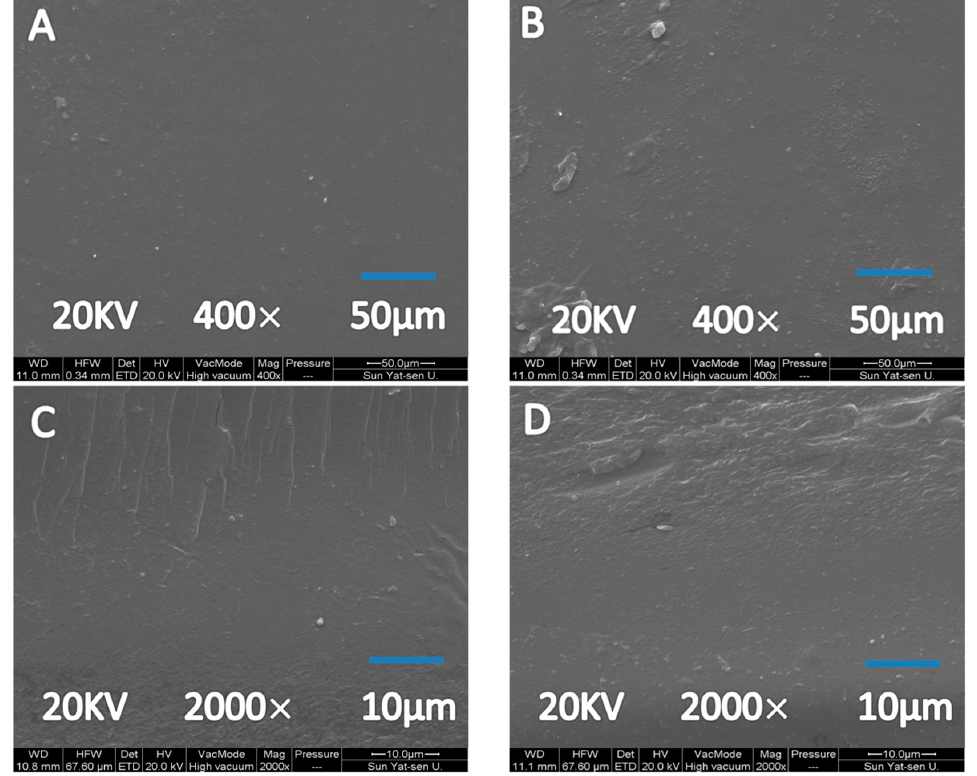
Figure 3. SEM images of surface morphology of GDC40-0 ( A ) and GDC40-5 ( B ), and cross-section morphology of GDC40-0 ( C ) and GDC40-5 ( D ).